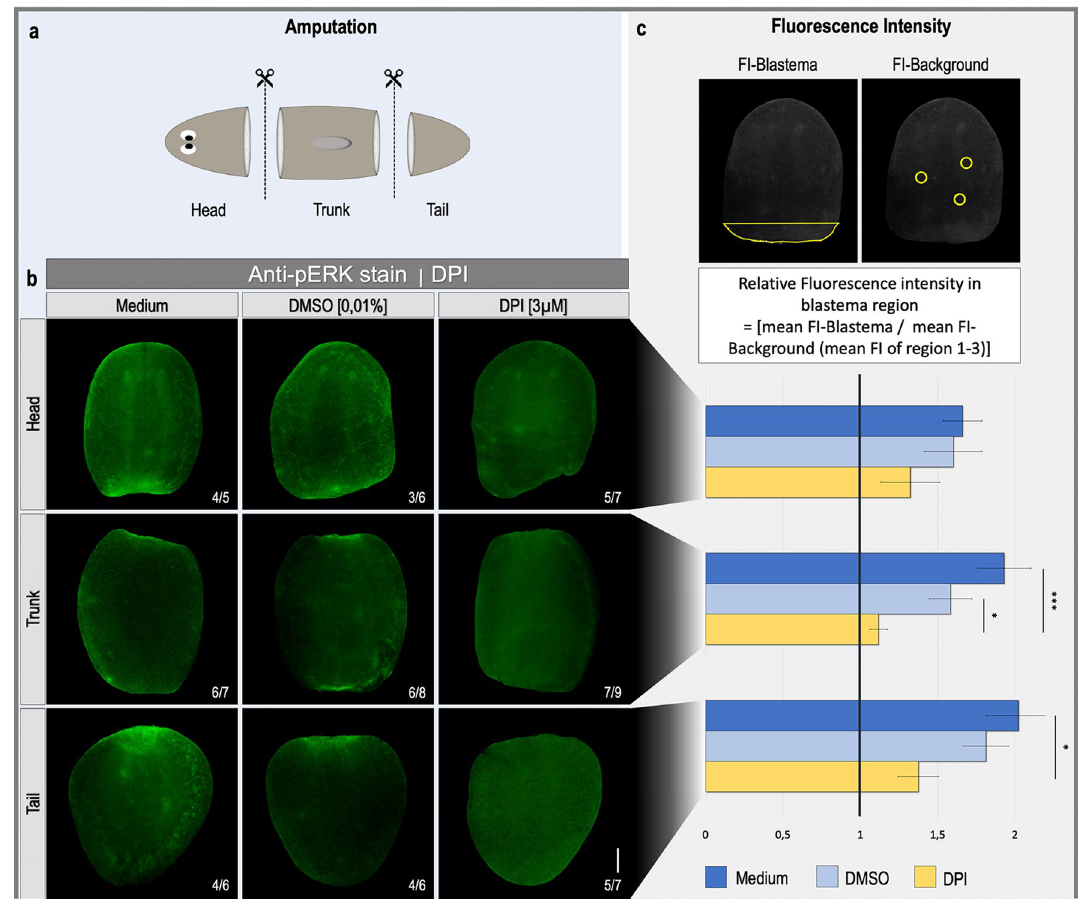
Figure 4. pERK activation decreases after the inhibition of ROS production ( a ) The amputation setup is displayed in the light blue box, indicating the amputation sites. ( b ) Immunostaining with an anti-pERK antibody on 1-day regenerating fragments. Animals kept in culture medium or 0.01% (v/v) DMSO were used as control animals, while in the treatment group, ROS production was inhibited with DPI (3 μM) administered in the culture medium during regeneration. All pictures were taken under the same light intensity settings. Sample numbers are indicated in the images. Scale bars 100 µm. ( c ) Relative fluorescence intensity of the blastema region. Setup of the measurement is indicated in the upper panel while the mean relative fluorescence intensity is displayed in the graph below. Color code as follows; dark blue: control in culture medium, light blue: control in 0.01% DMSO, yellow: 3 μM DPI. Statistical significance is indicated by: * p < 0.05; ** p < 0.01; *** p <